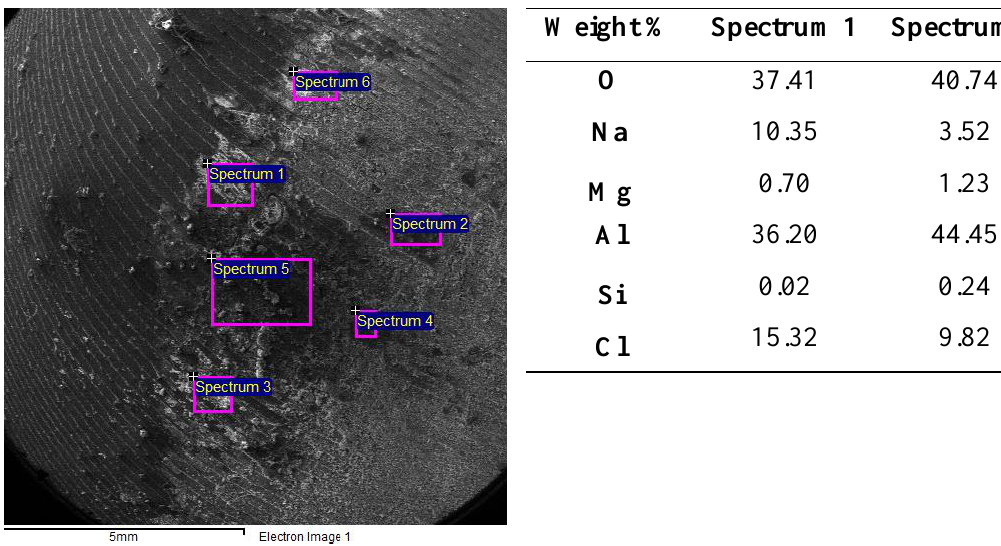
Figure 12. Energy dispersive spectroscopy (EDS) analysis (of sample FL-1) after 21 days of immersion in 3.5% NaCl showing the composition of typical corrosion product.